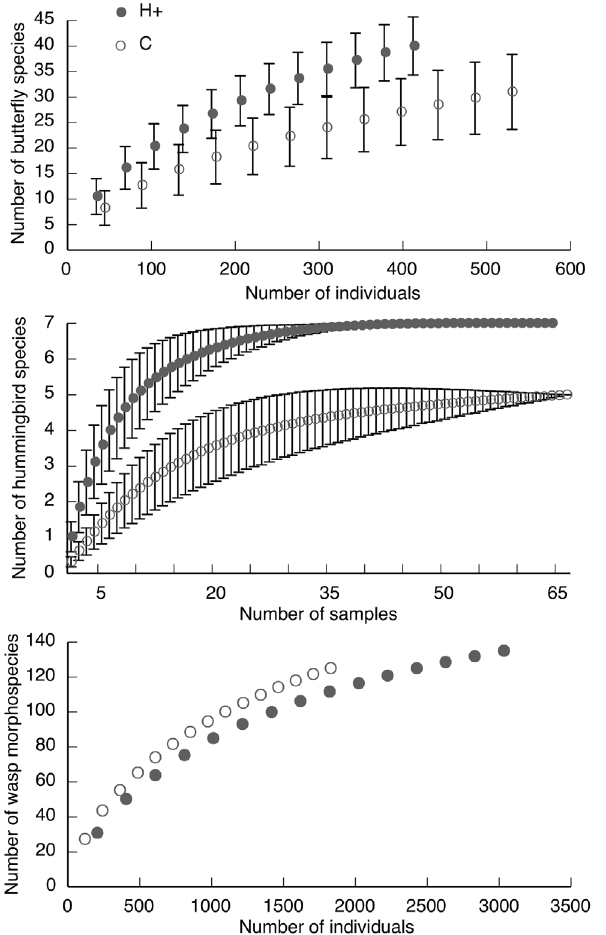
Figure 5. Sample-based rarefaction curves of control and treatment coffee agroforests. Curves compare treatment (H + ; supplemental steady-state floral resources) and control (C) coffee agroforests using Mao Tau expected richness in EstimateS. Rarefaction was performed on presence/absence data for hummingbirds (a) and abundance data for butterflies (b) and wasps (c). Curves were rescaled by the number of individuals for butterflies and wasps to compare species richness between agroforest types, and show the mean 6 95% CI. Non-overlapping CI show statistically significant group differences.